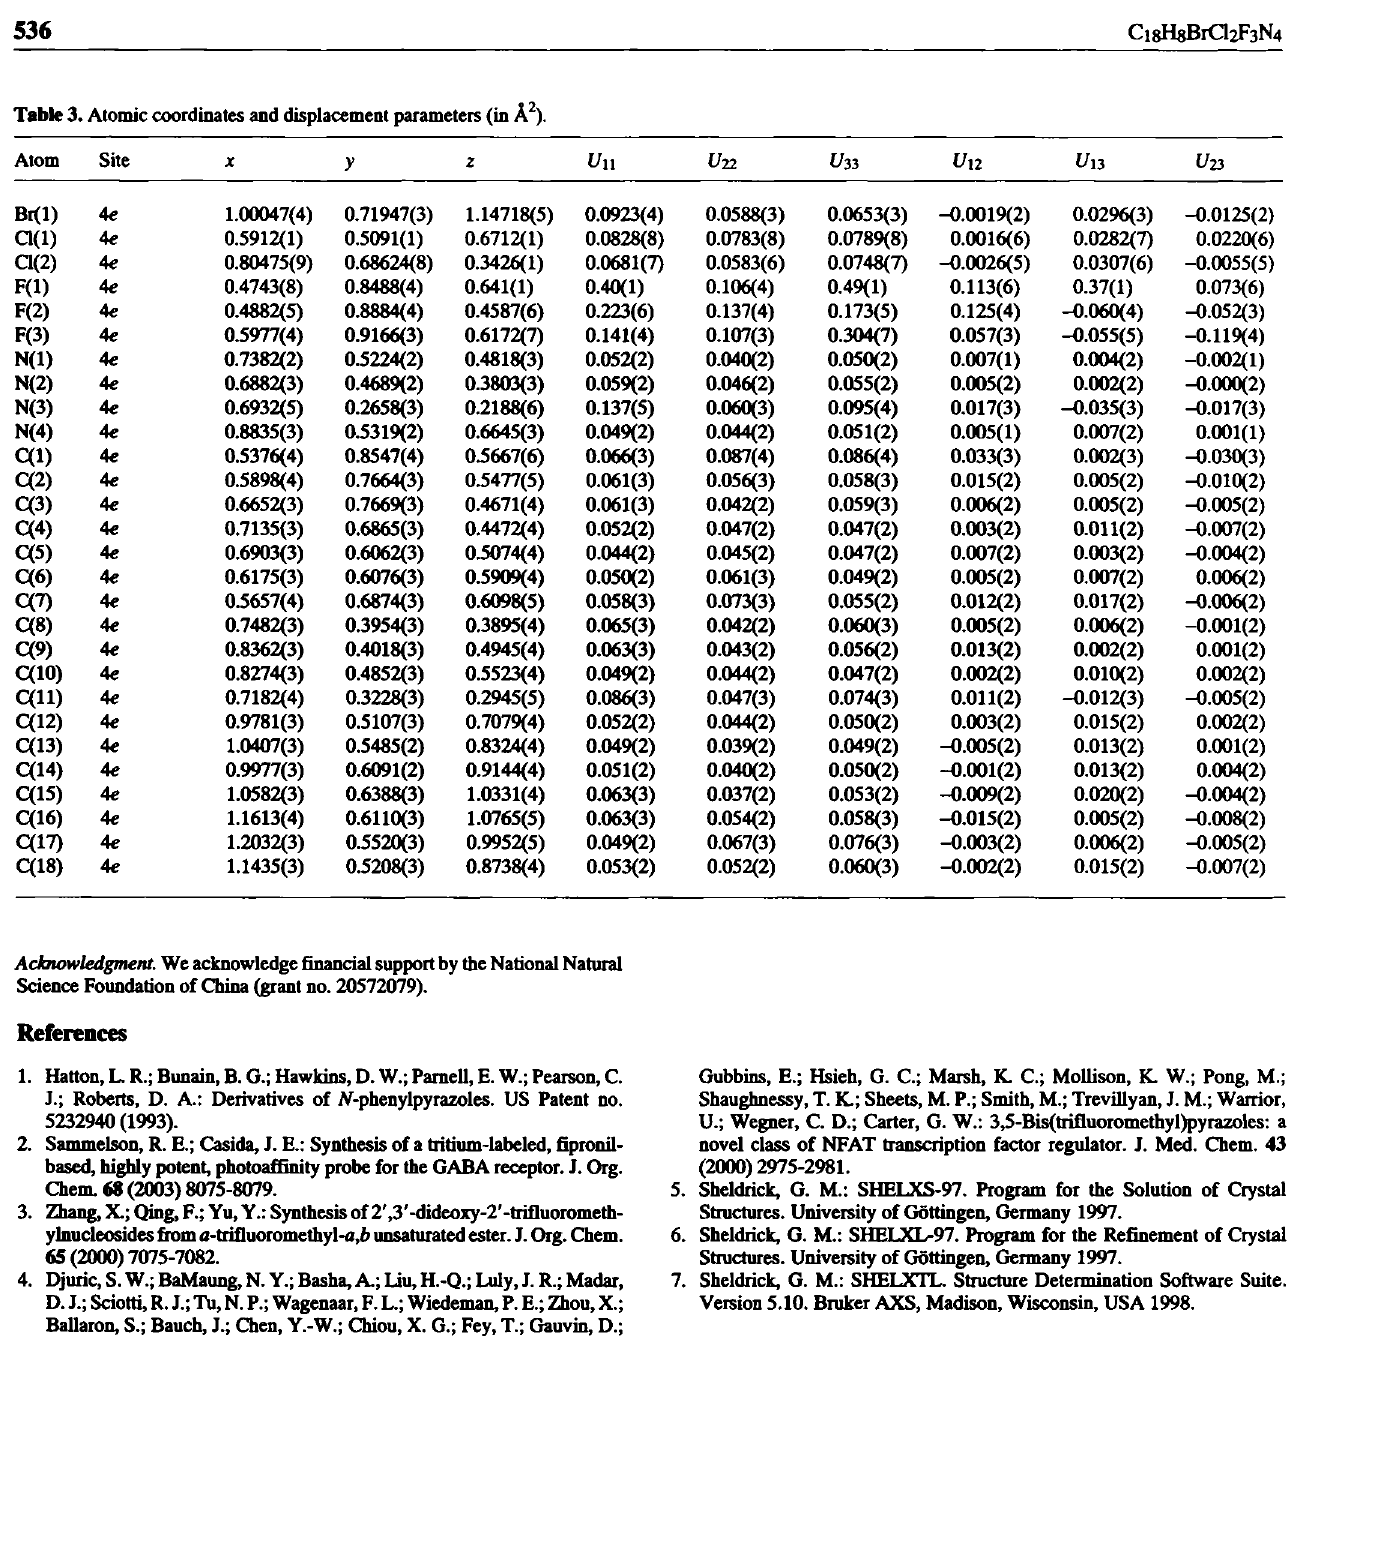
Table 3. Atomic coordinates and displacement parameters (in Ä 2